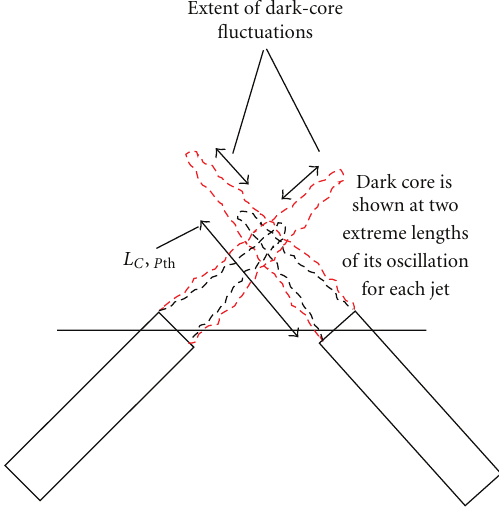
Figure 31: This figure shows the extent of the dark-core (or break- up) length fluctuations for individual jets of an impinging injector design for a situation when the average length ( L C , P th ) is of the same order as (or less than) the distance from each hole to the impinging point. Chehroudi